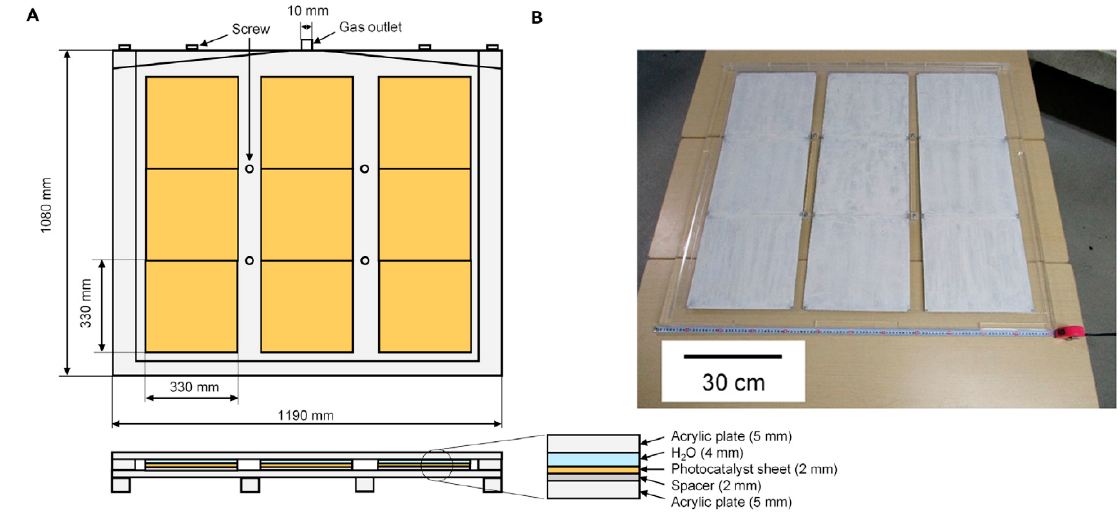
Figure 6. ( A ) Schematics of the 1 m square water photo ‐ splitting panel. Nine 0.6% ‐ STH RhCrO x /Al:SrTiO 3 photocatalyst sheets (33 cm × 33 cm for each) were arrayed in the reactor enveloped with transparent acrylic Plexiglas boards. A hydrophilized acrylic plate was used as the window. This panel was placed outdoor, with 10 ◦ tilt angle from the ground. The total weight of this panel, involving the reactant pure water, was approximately 4 kg. ( B ) A photograph of a 1 m square Al:SrTiO 3 panel. (Reproduced from [38].)